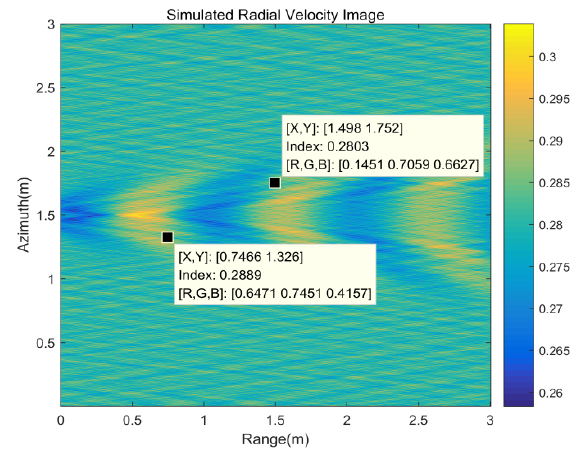
Figure 6. Kelvin wake wave radial velocity image.